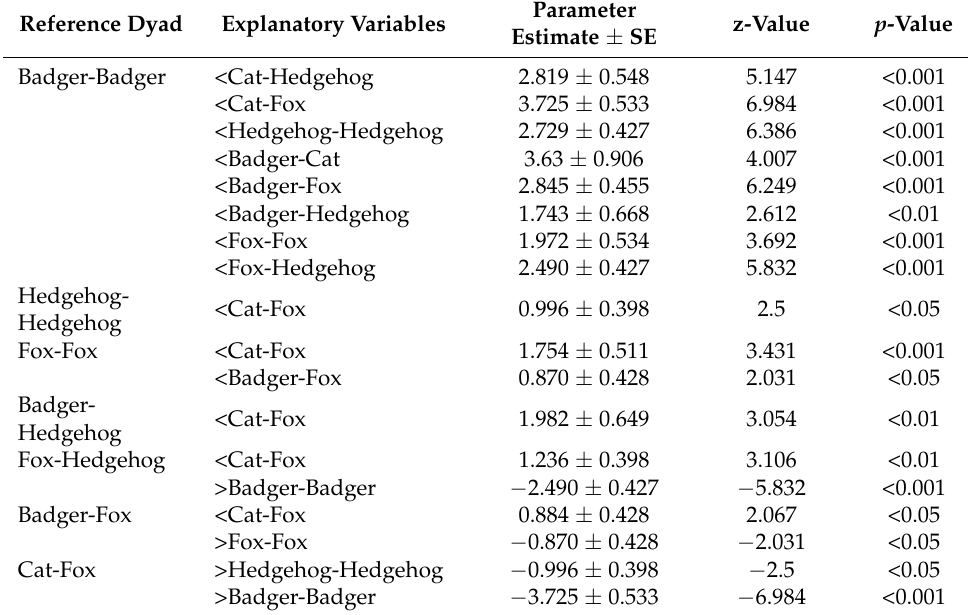
Table 3. Generalized Linear Models (GLM) of the test results investigating the effects of intraspecific and interspecific dyadic composition on interaction type (Neutral = 0; Agonistic = 1), using the relevel command in R to switch the levels to investigate all dyad comparisons against each other. Dis- played are parameter estimates ± standard error, z-value and p -value for each pairwise comparison. ‘<’ agonistic interactions are greater than the reference dyad and ‘>’ are less than the reference